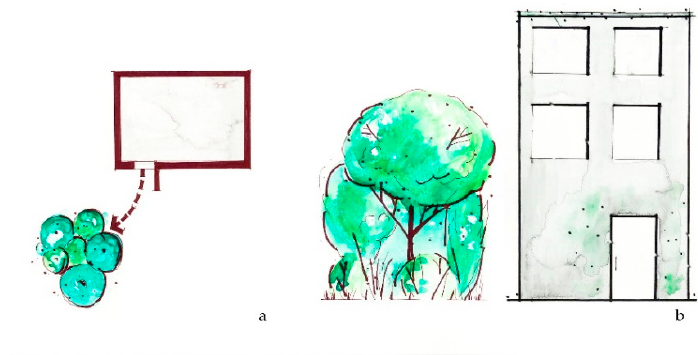
Figure 4. Bring nature nearby suggests providing close access to green for all member of society, including adding trees and plants within close proximity of everyone, regardless of demographic, cultural or socio-economic conditions. ( a ) Plan view of nearby nature; ( b ) Sketch elevation of green space near to a building.